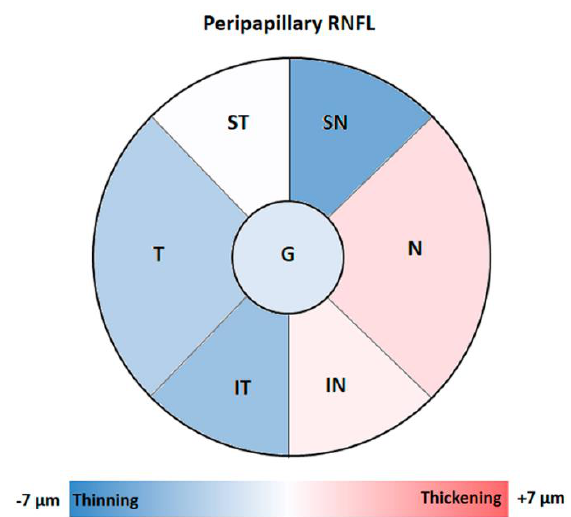
Figure 4. Colorimetric differences in the peripapillary RNFL thickness between the groups. FH+ ApoE ɛ 4 carriers vs. FH − ApoE ɛ 4 non-carriers in the peripapillary OCT sectors. In red, thickening; in blue, thinning. (ST: supero-temporal; SN: supero-nasal; N: nasal; IN: infero-nasal; IT: infero-temporal; T: temporal and G: global). Non-statistical differences were observed.